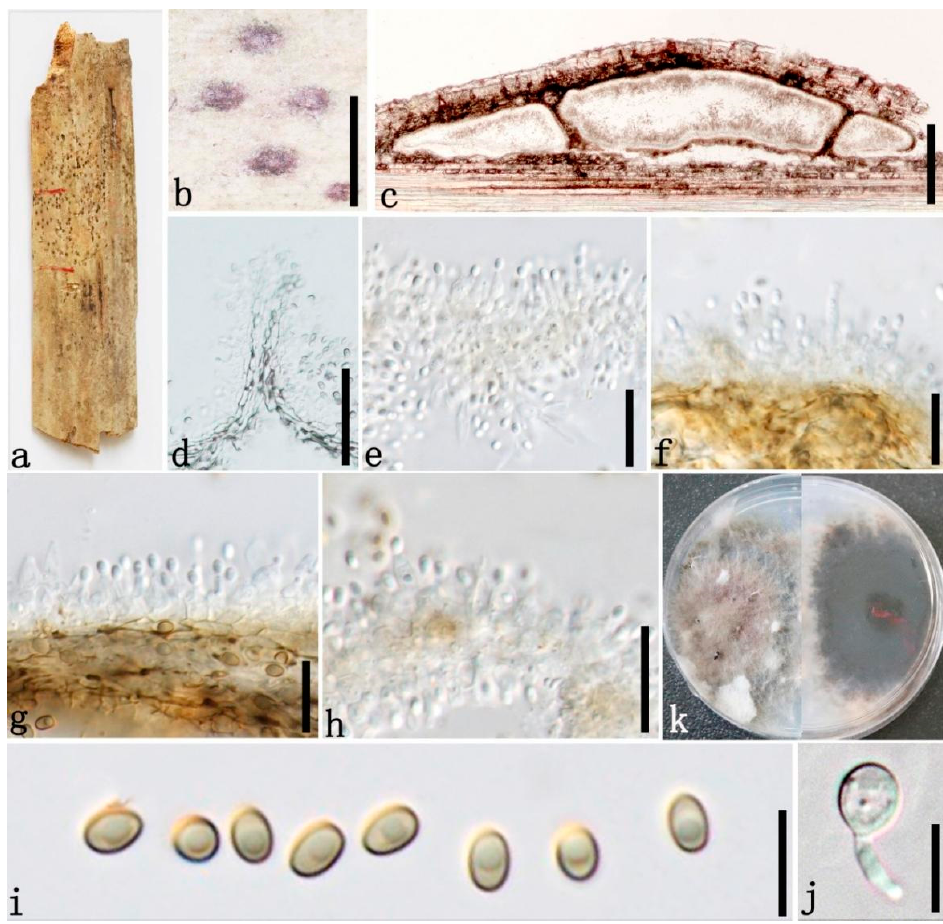
Figure 8. Roussoella padinae (GMB1320, first report of asexual morph, first record from terrestrial habitat and first record from China). ( a ) Bamboo specimen; ( b ) reddish-brown conidiomata on host surface; ( c ) vertical sections of conidiomata; ( d ) conidioma wall; ( e – h ) conidiogenous cells; ( i ) conidia; ( j ) germinating conidium; ( k ) cultures on PDA from above and below. Scale bars: ( b ) = 1 mm, ( c ) = 150 μ m, ( d ) = 30 μ m, ( e – h ) =15 μ m, ( i ) = 5 μ m, ( j ) = 10 μ m.